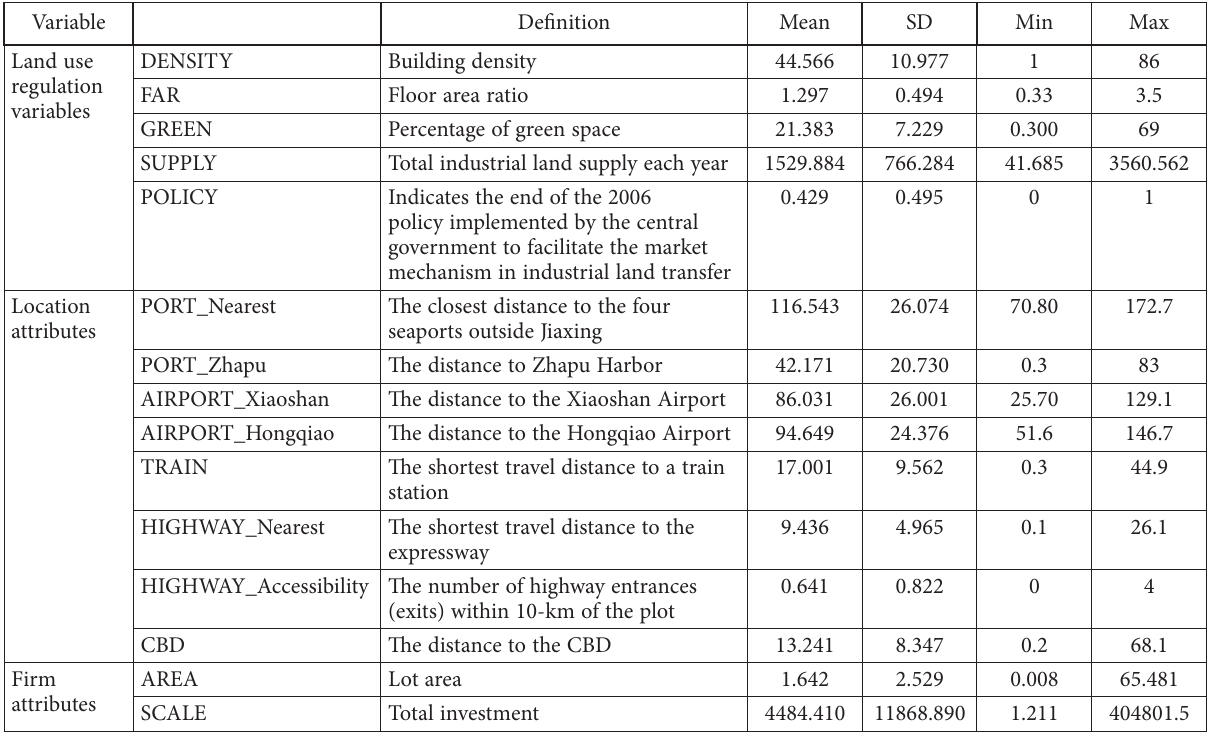
Table 1. The definition and description of the variables in the